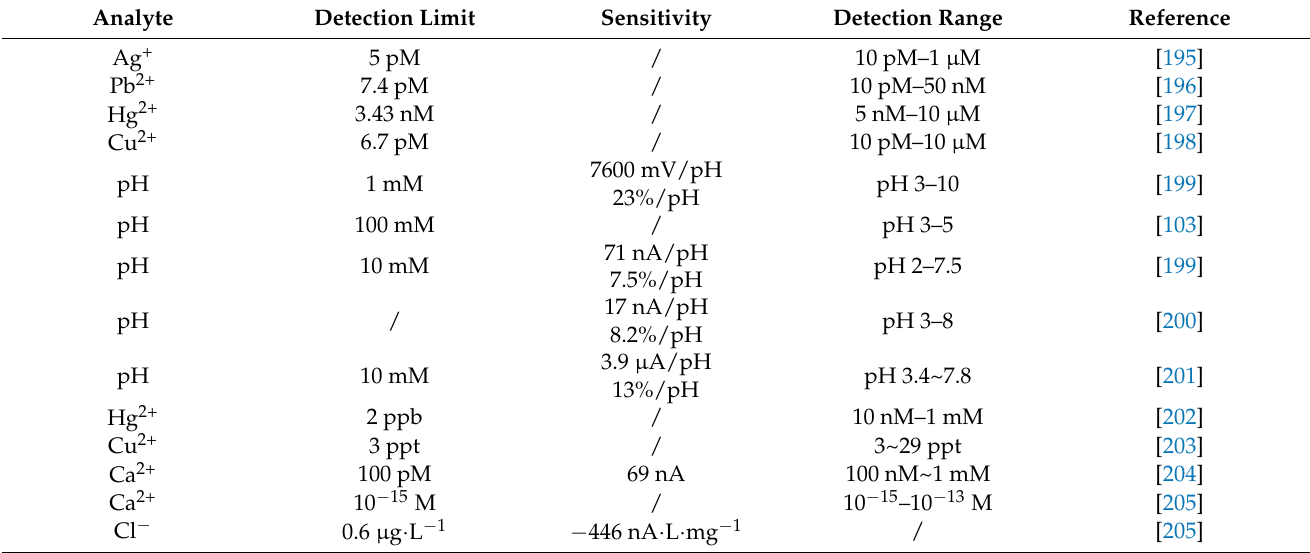
Table 4. Ion detection based on